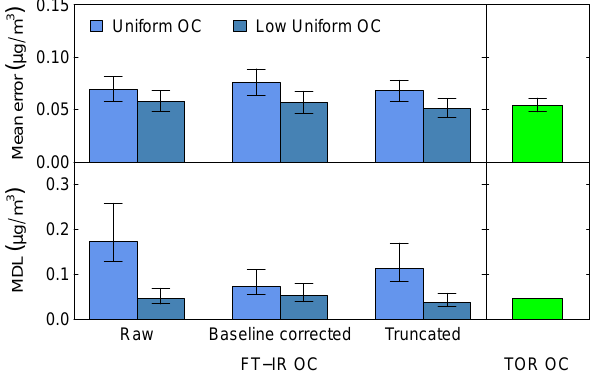
Figure 7. Mean error and MDL for the Uniform OC (which in- cludes the full range of OC) and the Low Uniform OC cases for all three spectral types. Collocated TOR OC precision and MDL for TOR samples in the same mass range as the Low Uniform OC case (OC < 15µg) are shown for reference. The error bars indicate the 95% confidence intervals on these point estimates. Absolute er- rors are compared directly because the same test set is used for both cases (FT-IR OC), or for samples in the same concentration range (TOR